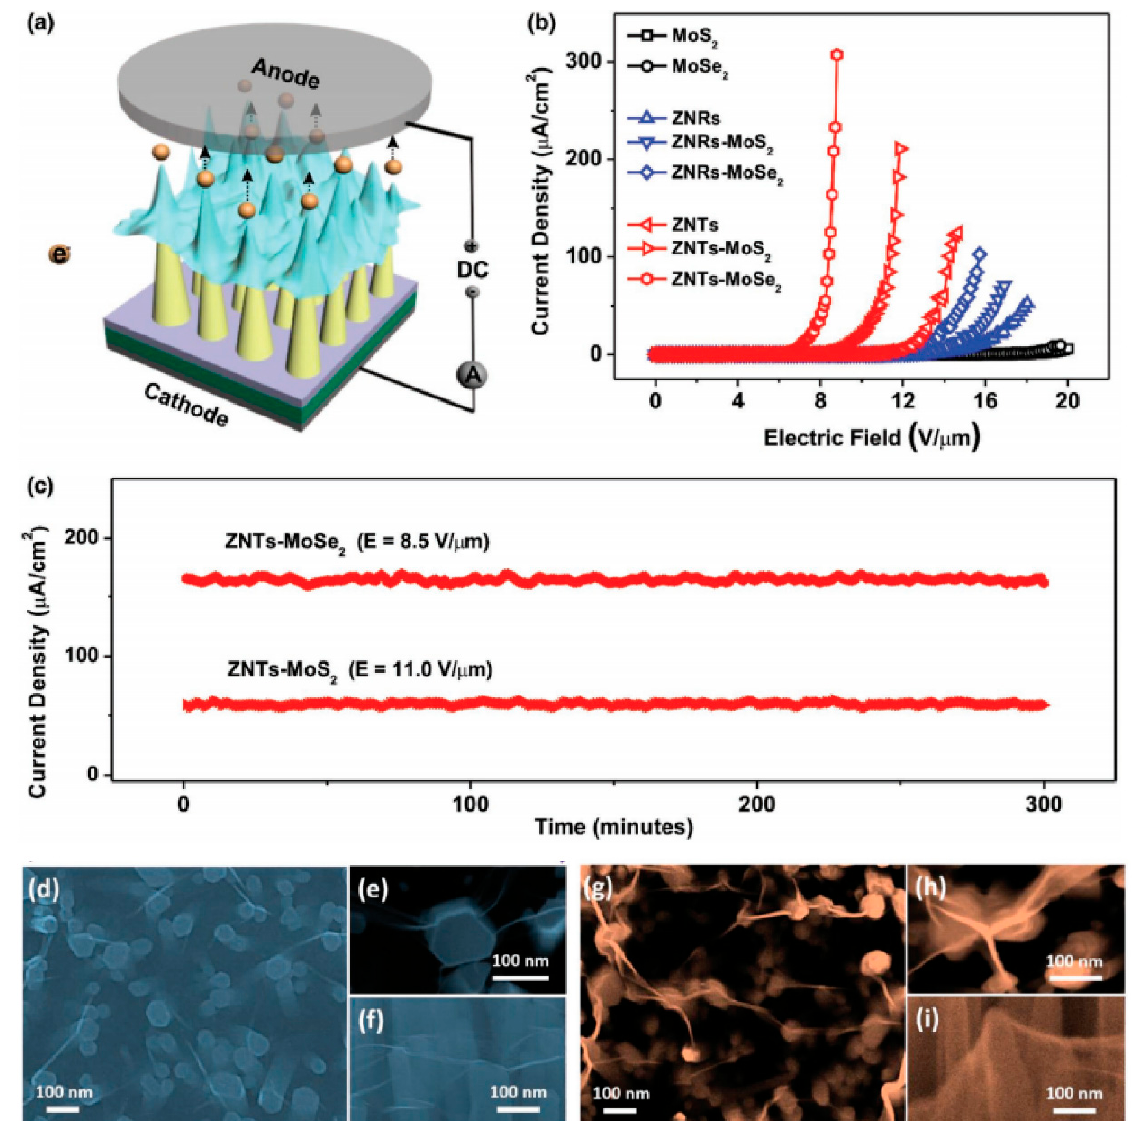
Figure 25. The measurement setup ( a ), field emission J-E curves ( b ) and stability ( c ) of the hybrid field emitters. The SEM images of the transition metal dichalcogenide (TMD) on ZnO nanorods ( d – f ) and TMD on ZnO nanotapers ( g – i ). Reproduced from [98], with the permission of John Wiley and Sons, 2017.